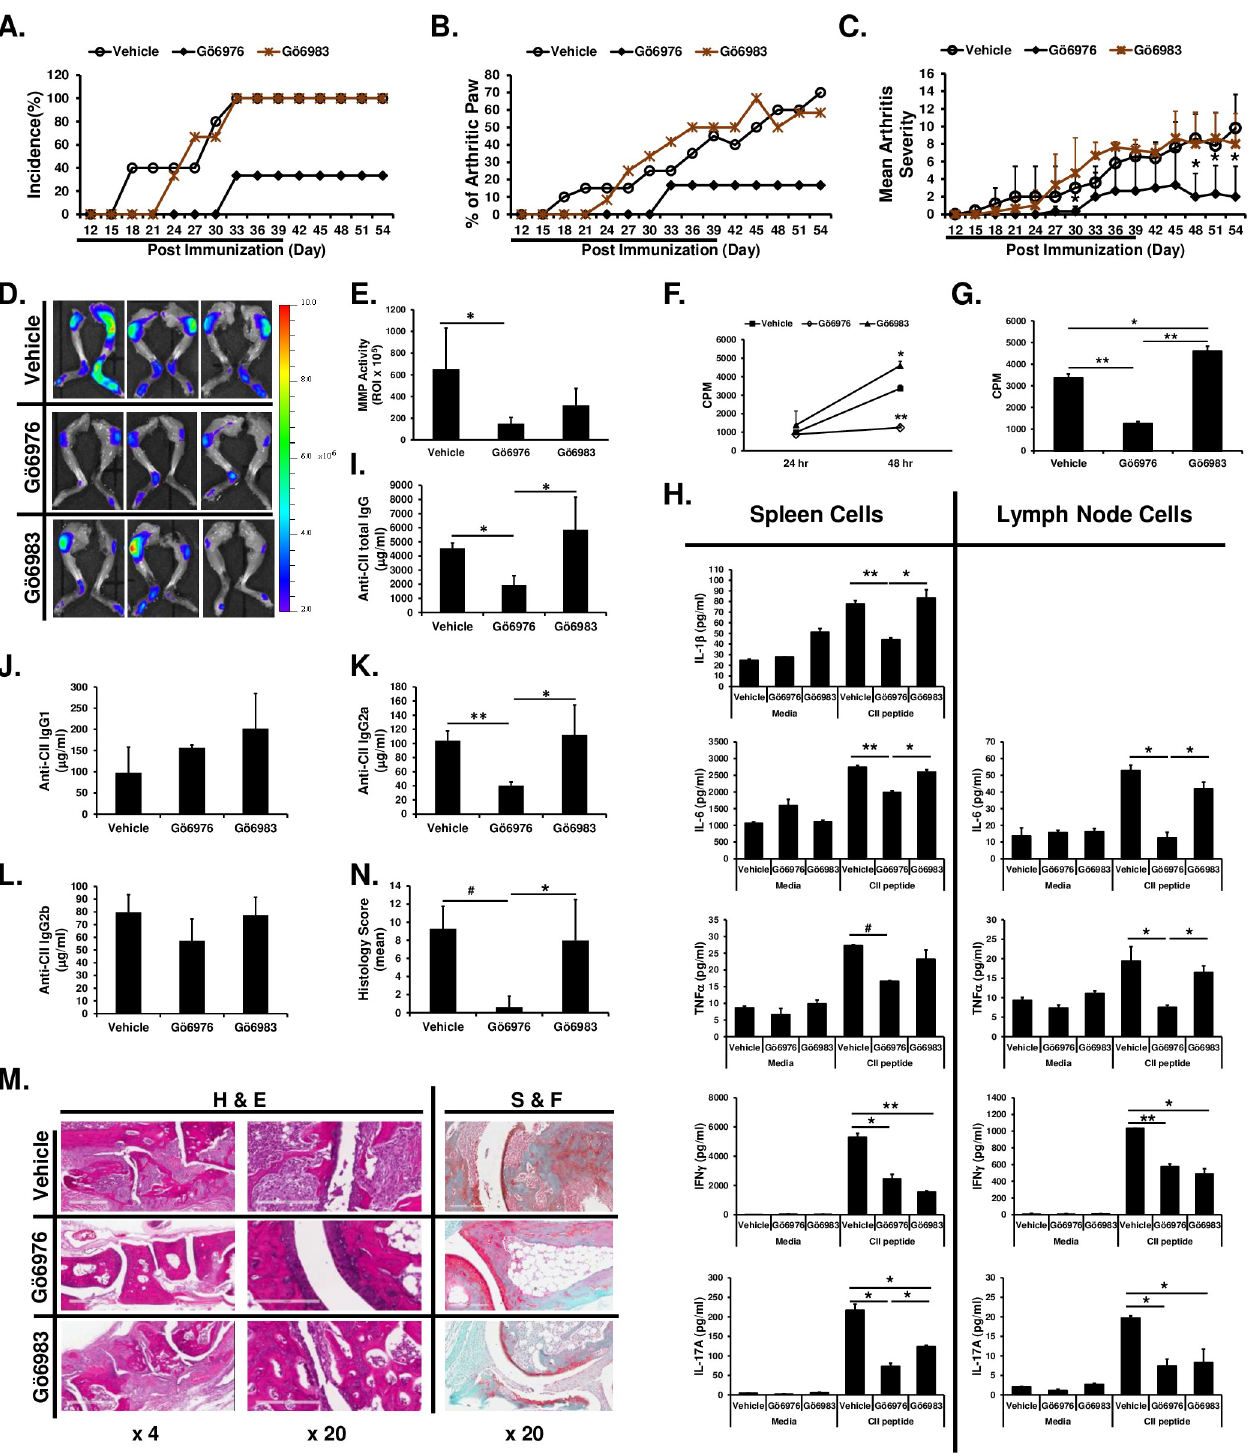
Fig 4. Differential effects of Go¨6976 and Go¨6983 on CIA. HLA-DR1 mice were immunized with bovine CII and treated daily with vehicle (n = 5), Go¨6976 (n = 3), Go¨6983 (n = 3) for 39 days (indicated as underline) starting at the day of CII immunization. Mice were observed daily and development of arthritis was assessed up to 54 days post immunization. (A) Incidence of arthritis. (B) The % of arthritic paws. (C) Mean arthritis severity score. Data represent the mean ± SD. � , p < 0.05. (D—E) At day 54, mice were injected i.v. with MMPSense 1 750 FAST Fluorescent Imaging Agent (750F). Twenty four hours later, mice were anesthetized and then scanned using IVIS 1 Lumina XR System (D). Fluorescence intensities were quantified within ROI by using Living Image